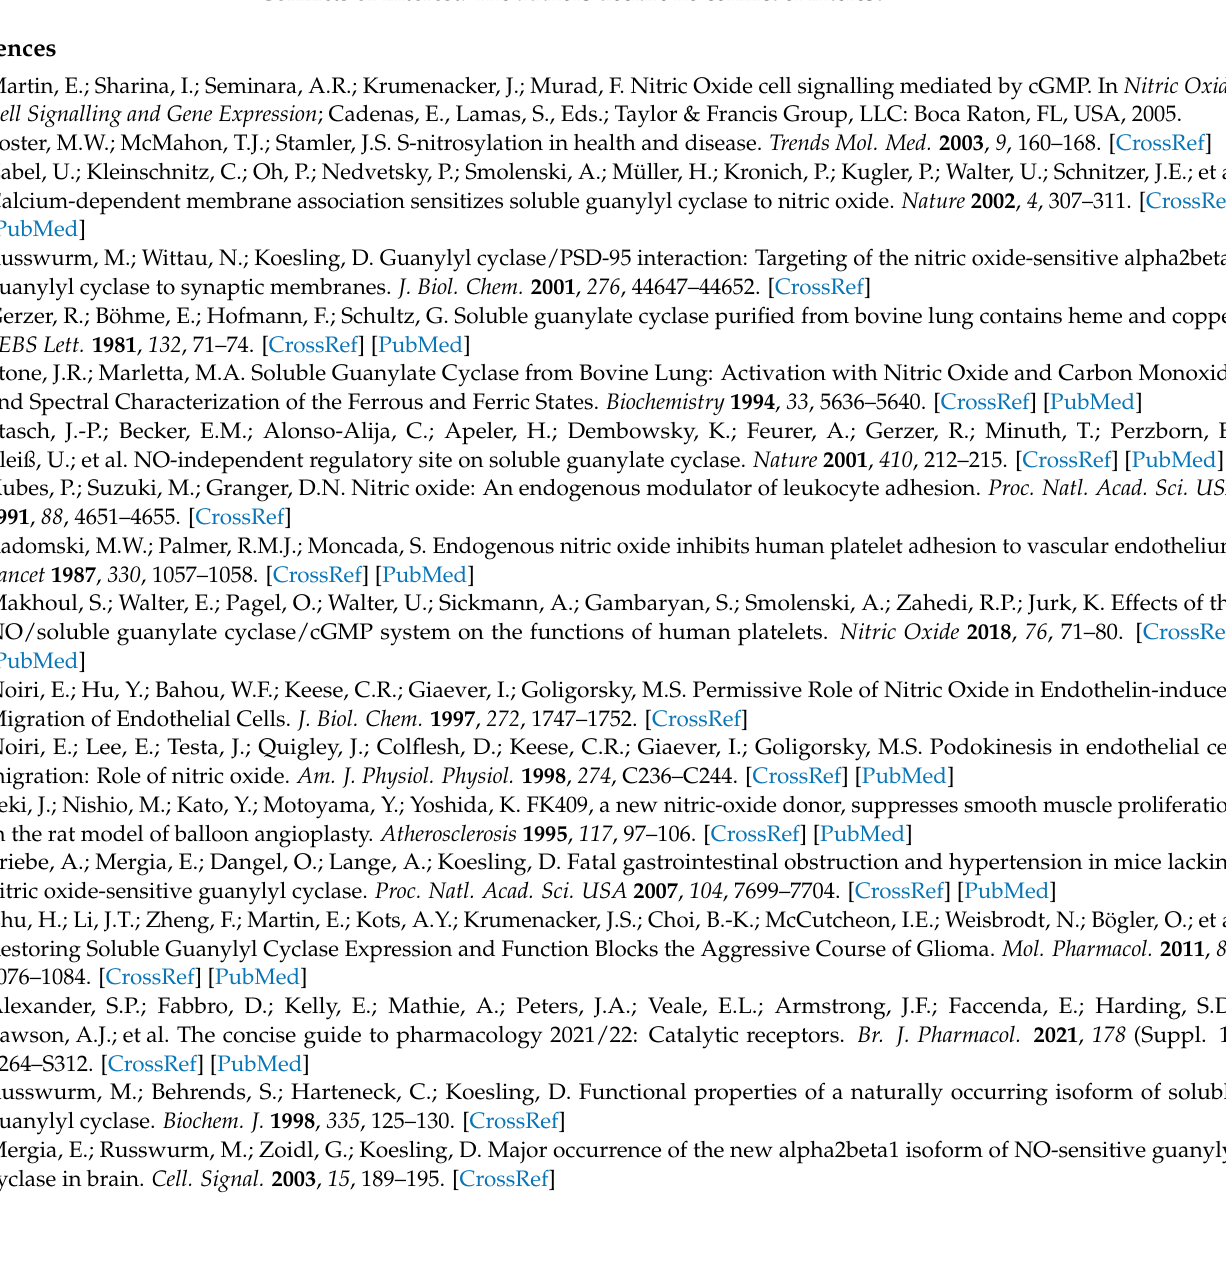
figure preparation: E.M. All authors have read and agreed to the published version of the